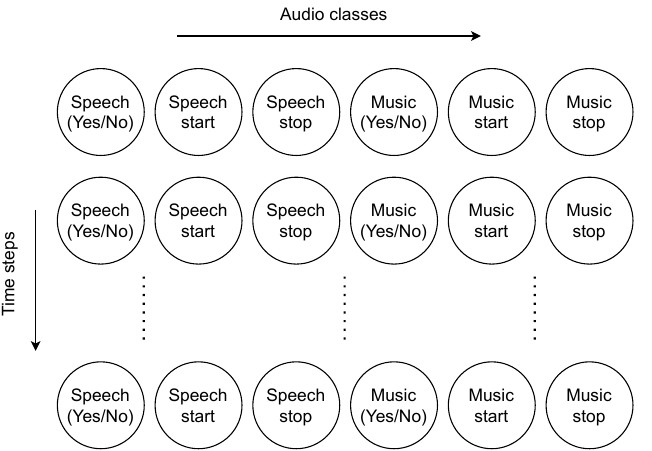
Figure 2. An illustration of the output layer of the YOHO algorithm. This network is for music-speech detection. To increase the number of audio classes, we add neurons along the horizontal